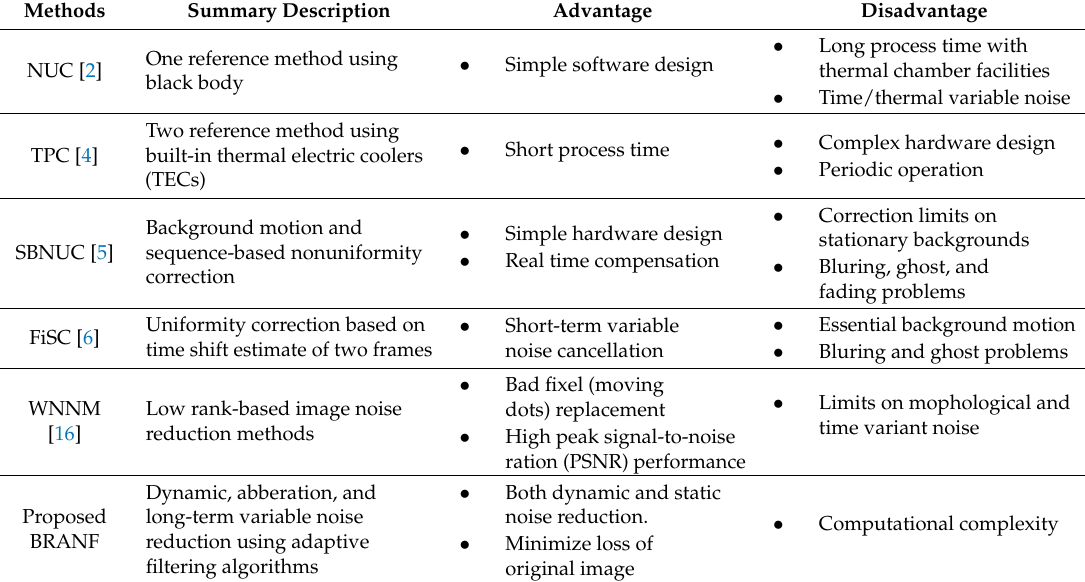
Table 2. IR image quality improvement methods: Non-uniformity correction(NUC), two-point correction (TPC), scene based NUC (SBNUC), feedback-integrated scene cancellation (FiSC), weighted nuclear minimization(WNNM) and the proposed background registration-based adaptive noise filtering (BRANF)